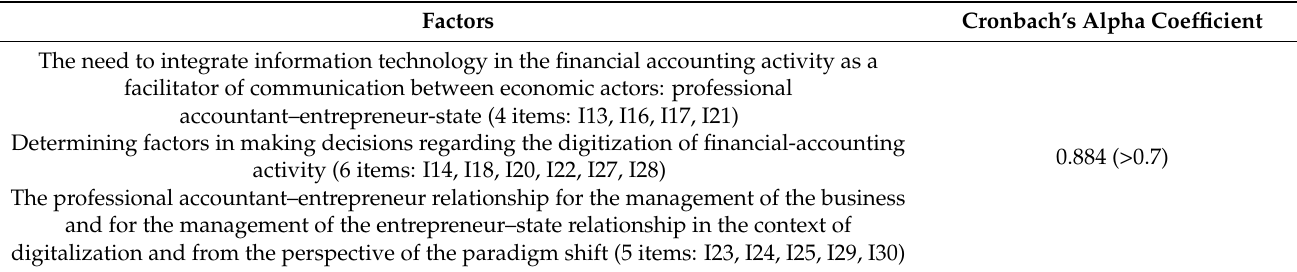
Table 2. Cronbach’s Alpha coefficient. Factors